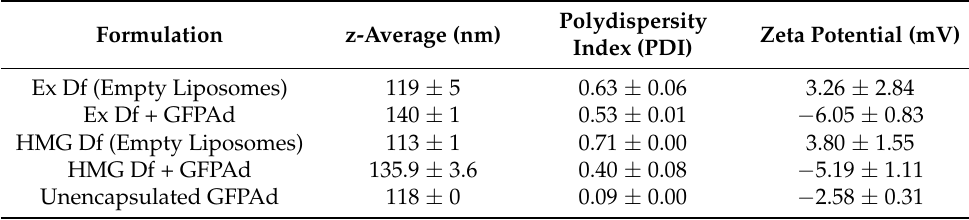
Figure 4. Comparative in vitro transduction of Ad liposomes manufactured by extrusion and homogenization on CAR deficient CT26 cancer cell line (n = 3): ( A ) Liposomes manufactured by extrusion (red bar) and homogenization (blue bar) demonstrated similar transduction ( p value: ns = not significant). Compared to unencapsulated GFP Ad (yellow bar is not visible in the chart due to a very low fluorescence intensity) both processes demonstrated significantly higher transduction ( p value: **** ≤ 0.0001) at MOI 50. ( B ) Comparative fluorescence microscopy images of unencapsulated GFPAd, Ex Df + GFPAd, and HMG Df + GFPAd at 20× and 200× magnifications. Table 2. Comparative particle size (z-average) using DLS, and zeta potential of Ad liposomes manufactured using different processes (n =